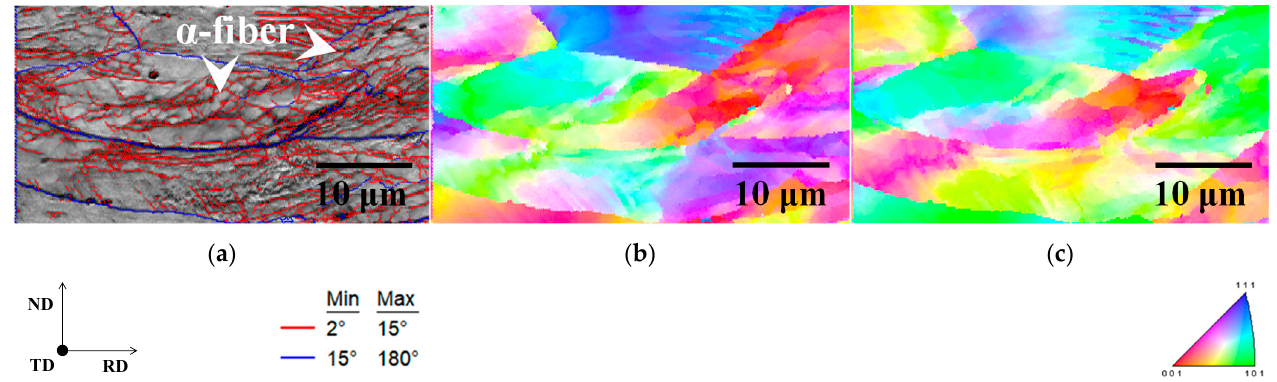
Figure 9. ( a ) Image quality with grain-boundary misorientation angle and inverse pole figure maps in the ( b ) normal and ( c ) rolling directions of specimen B heated to 823 K.